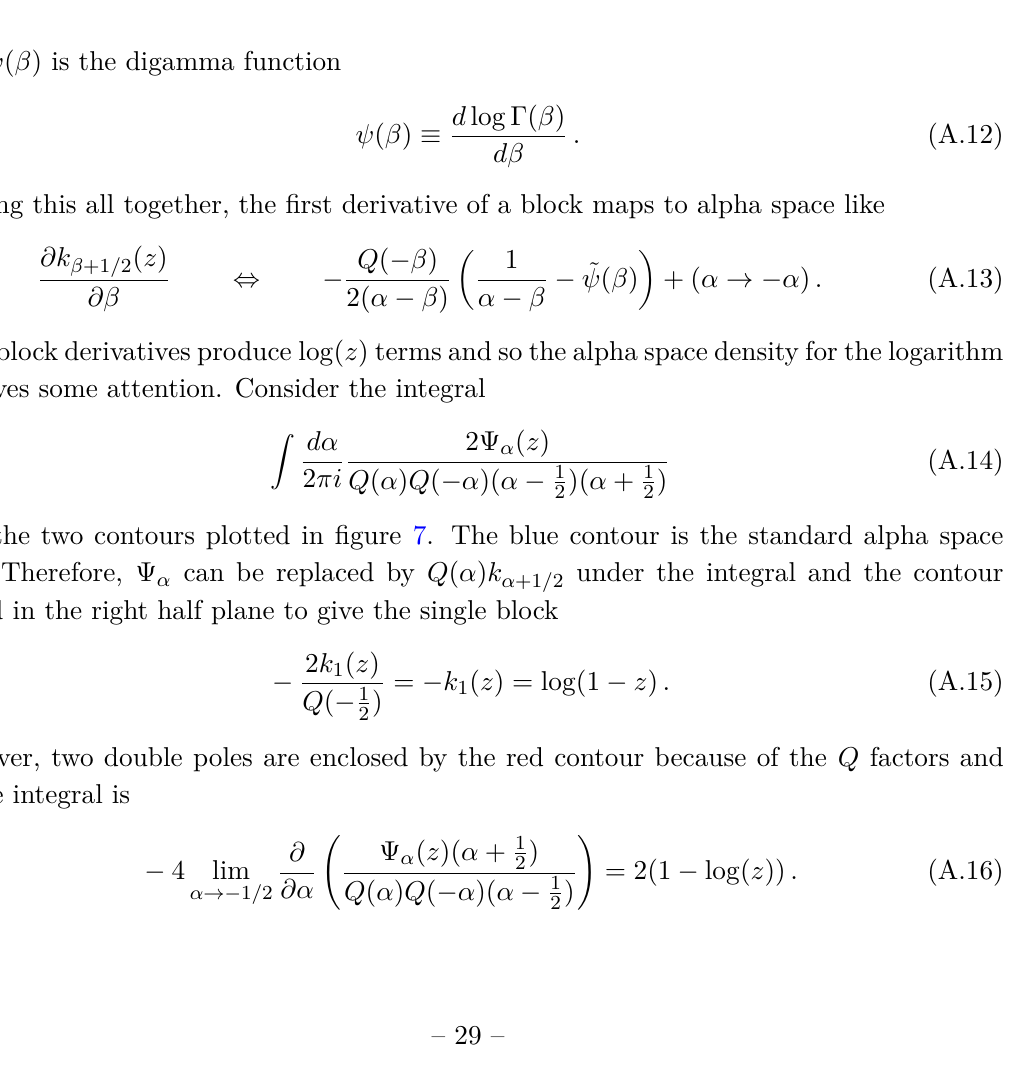
Figure 7 . Plotted are the contours for the integral eq. (A.14). The blue contour gives log(1 − z ) whereas the figure-of-eight red one gives 2(1 − log( z )) . The double poles at α = ± 1 / 2 are marked by black